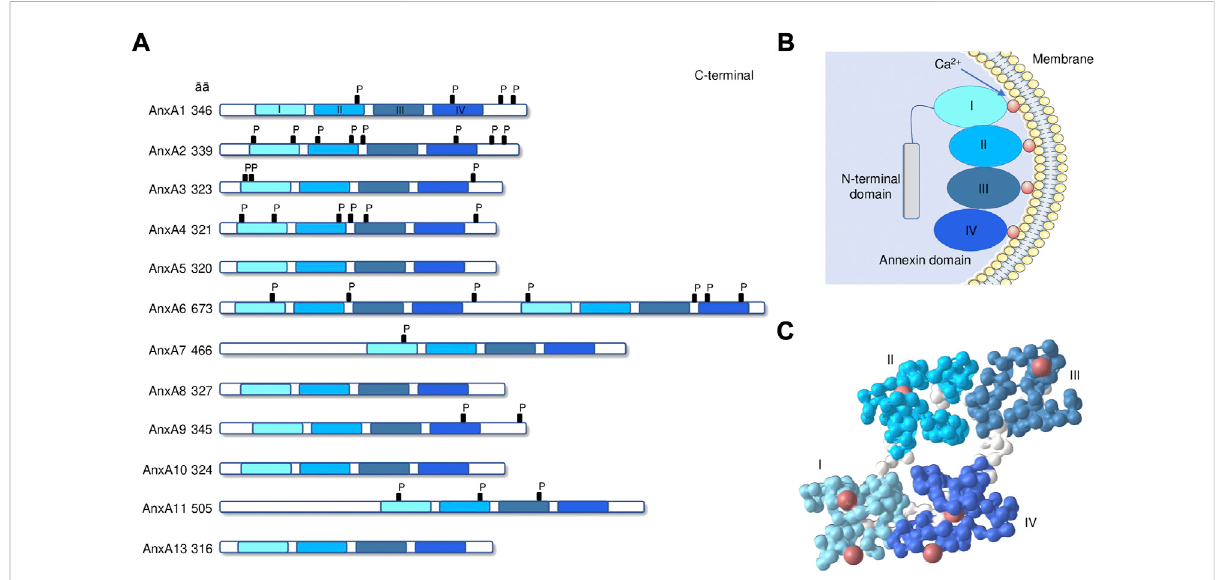
Annexin structure. (A) The domain structures of annexins AnxA1 to A13 are illustrated. C-terminal core with annexin repeats I – IV in light to dark blue and length (in amino acids) are indicated. P, known phosphorylation sites. (B) Schematic drawing of annexin peripherally attached to a membrane surface through bound Ca2+ ions. (C) 3D-structure of human AnxA1 (PDB: 1AIN [Weng et al., 1993]). Colors identify the 4 repeated domains (spacer regions in white), with coordinated calcium ions (red). 3D-structures are visualized with the iCn3D software vs. 3.15.1 (https://